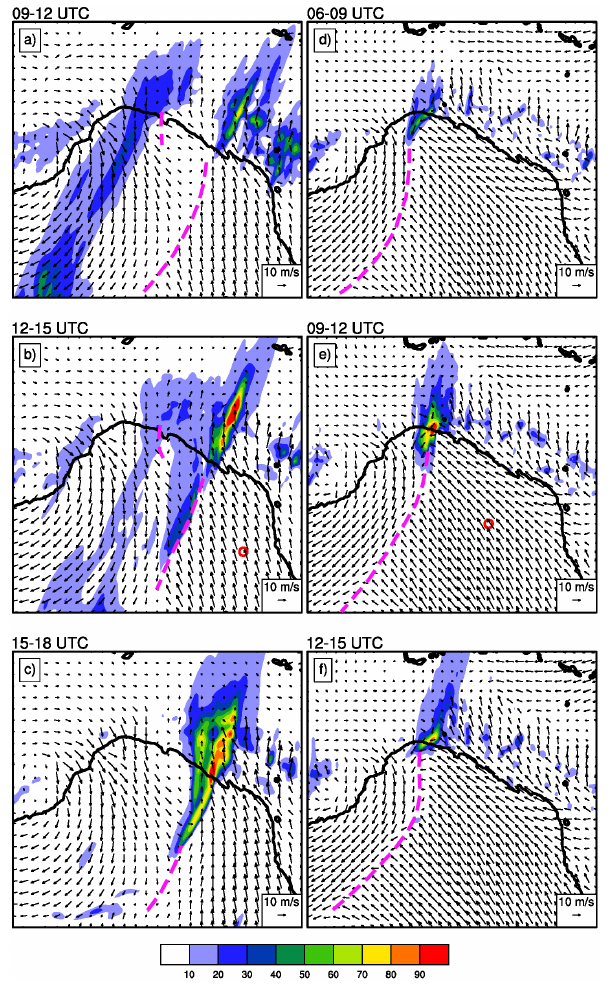
Figure 12. Precipitation accumulated every 3h and 10m wind aver- aged over the same interval, for MOLOCH forecasts. Left column: the CT case, run at 1.5km mesh size, starting from NOAA-GFS analysis at 00:00UTC of 25 October 2011. Right column: the GE case, run at 1.0km mesh size, starting from ECMWF-IFS analysis at 00:00UTC of 4 November 2011. The purple dotted lines mark the convergence lines. For the small red circles in (b) and (e) , see the captions of Fig. 13.